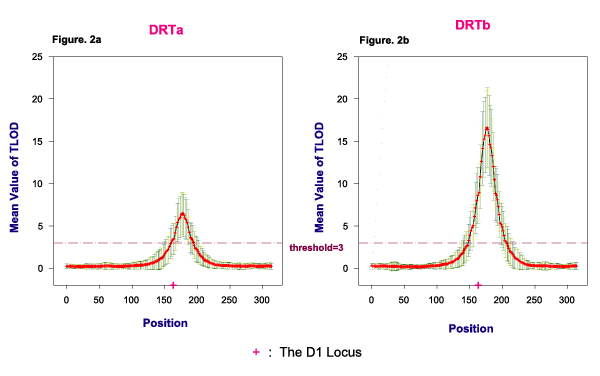
Mean value of TLOD for DRTa (a) and DRTb (b).